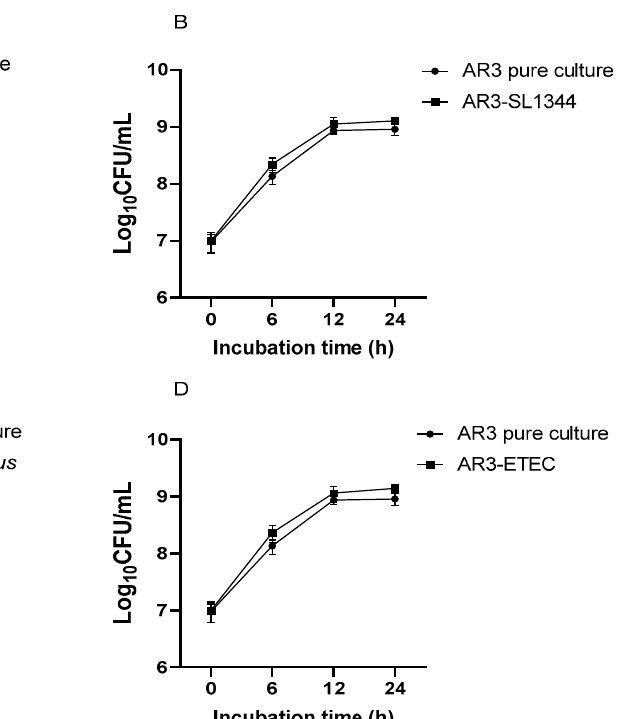
Figure 5. Growth pattern of L. acidophilus AR2 in pure culture and co-culture with S . Typhimurium ATCC14028 ( A ), S . Typhimurium SL1344 ( B ), S. aureus ( C ), and ETEC ( D ).